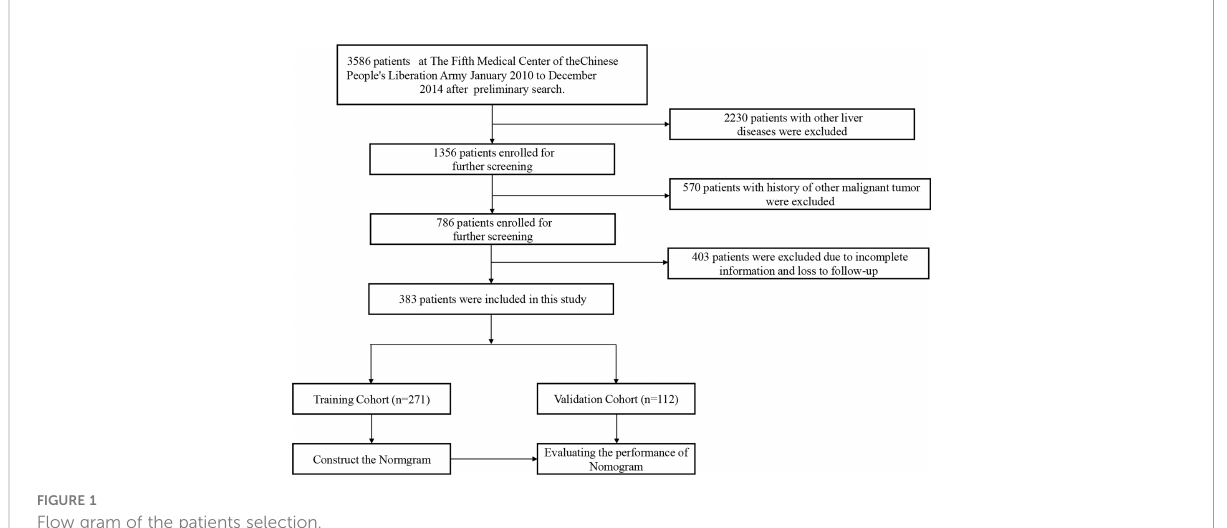
FIGURE 1 Flow gram of the patients